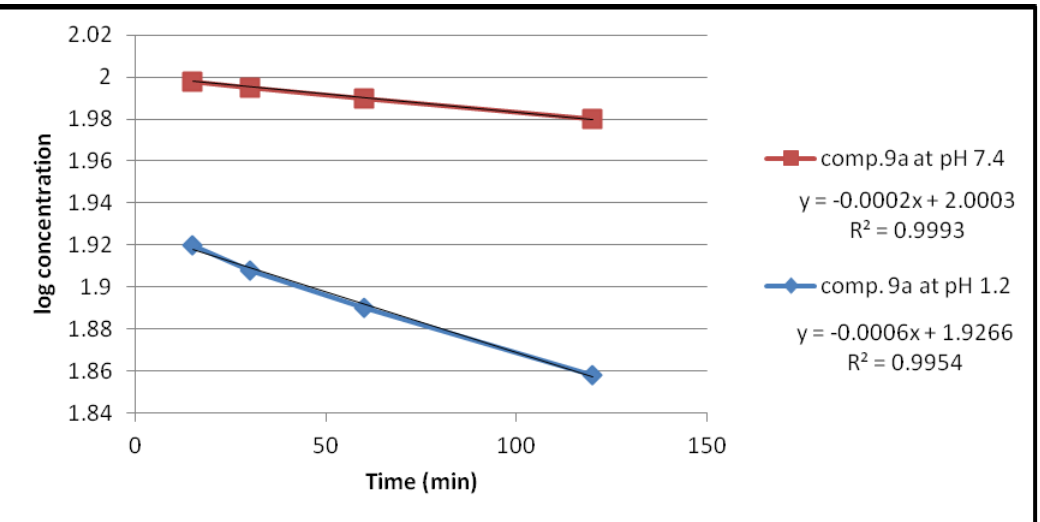
Figure 2. The hydrolysis rate of compound 9a at different pH values.